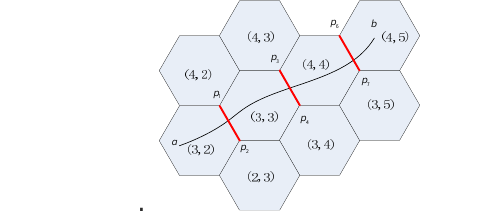
Figure 9. Terrain feature information mapping